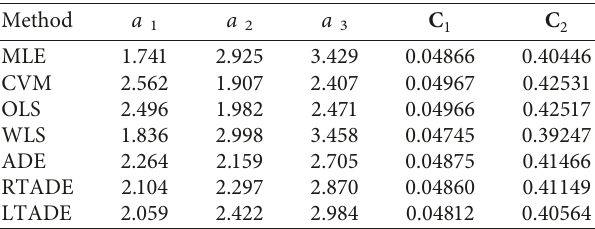
􏽢 C , 􏽢 C , 􏽢 C , and e j 1 j 2 j 3 j